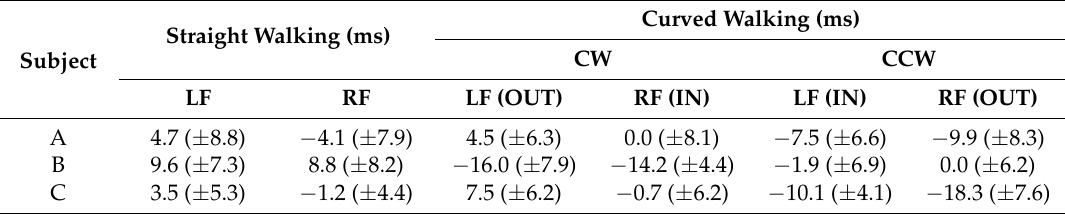
Table 1. Root-mean-square (RMS) differences in stance duration measurements between the Nintendo Wii Balance Board (WBB) and the force plate.